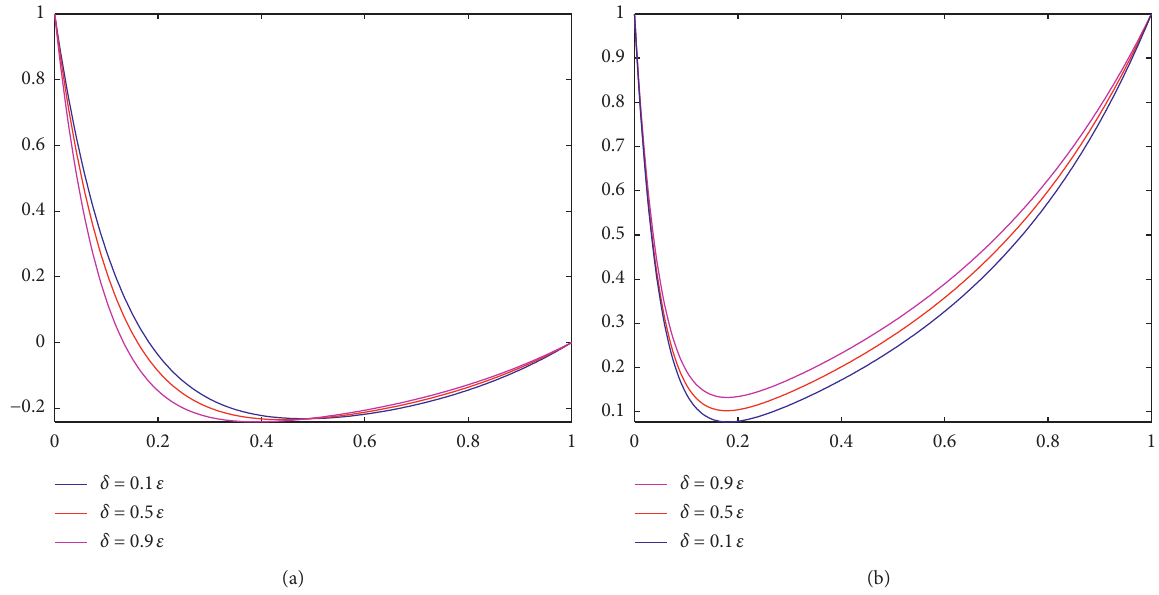
Figure 1: Effect of delay on the solution behaviour for ε � 2 − 3 . (a) Example 3. (b) Example